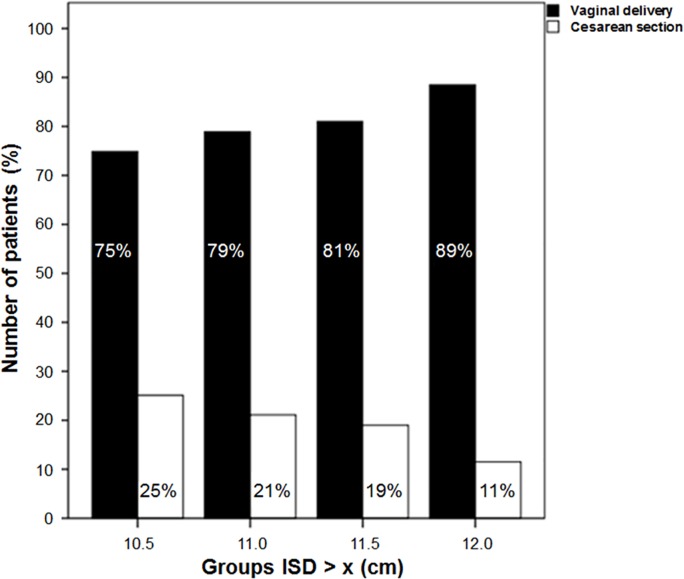
A comparison of the vaginal (black bars) and caesarean (white bars) breech deliveries according to the ISD.The study identified 175/240 (73%) patients with an ISD ≥10.5 cm, 109/240 (45%) patients with an ISD ≥11.0 cm, 63/240 (26%) patients with an ISD ≥11.5 cm and 26/240 (11%) patients with an ISD ≥12.0 cm.